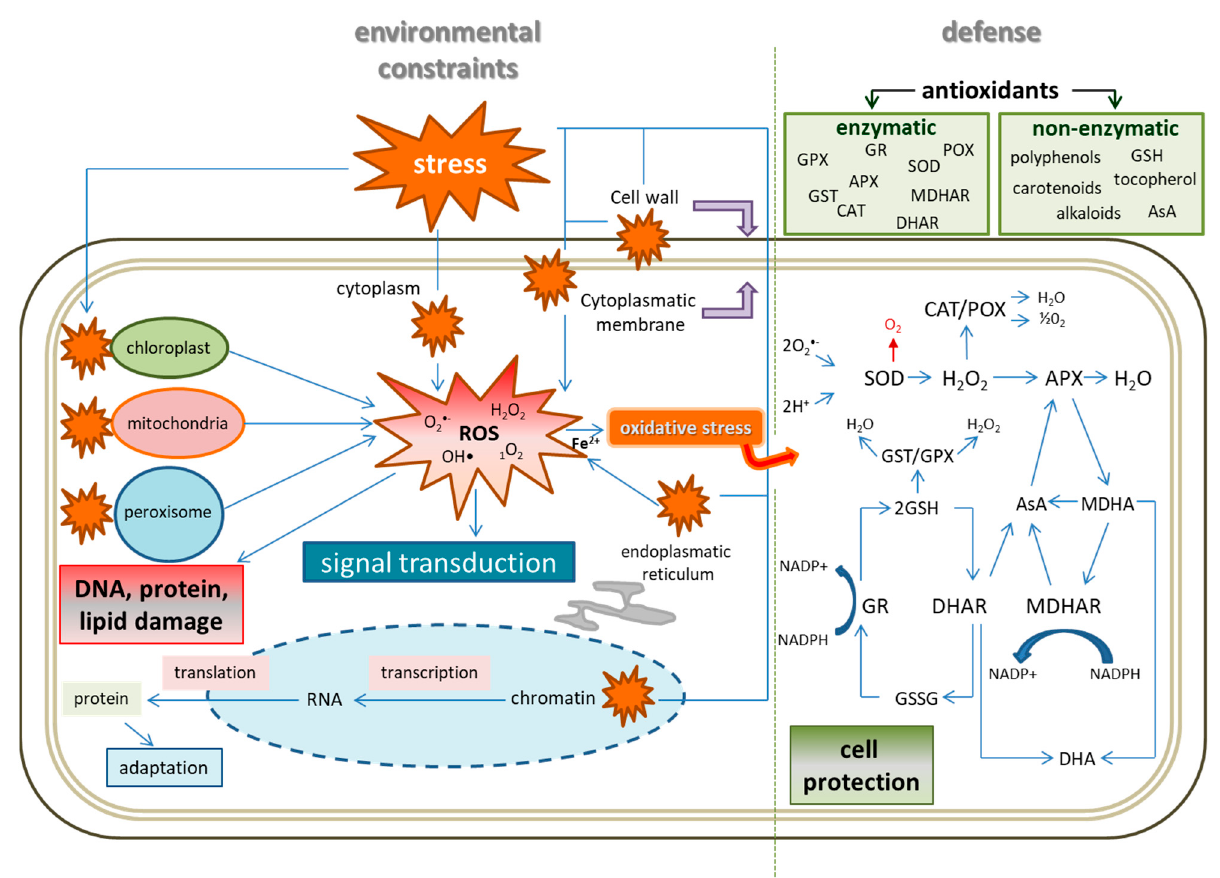
Figure 2. Stress acting through various cellular compartments triggers signaling events that involve second-wave messengers and regulatory proteins. Stress-derived changes in gene transcription, RNA processing, or post-translational modifications of formed proteins play crucial roles in the production and modification of proteins, triggering various responses to stress ranging from cell adaptation to apoptosis. Moreover, ROS signal sensors/receptors may induce activation of biosynthesis/functioning of different protective molecules (enzymatic or non-enzymatic antioxidants) capable of modulating individual metabolic and physiological pathways, thereby contributing to plant acclimation to various stresses (adapted from Zhang et al. [17] and Kapoor et al. [150]).